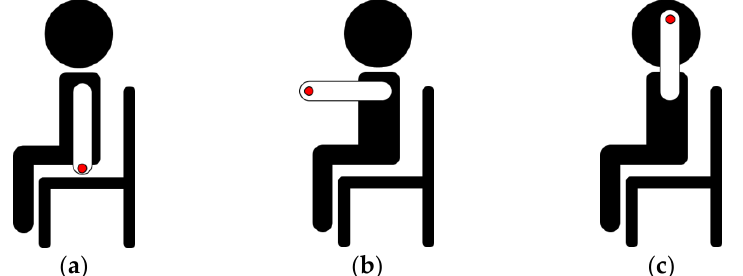
Figure 10. The three different postures for examining PPG measurement at different hydrostatic pressures: ( a ) Posture 1—hands down (−90 ° ); ( b ) Posture 2—hands forward (0 ° ); ( c ) Posture 3—hands up (+90 ° ).